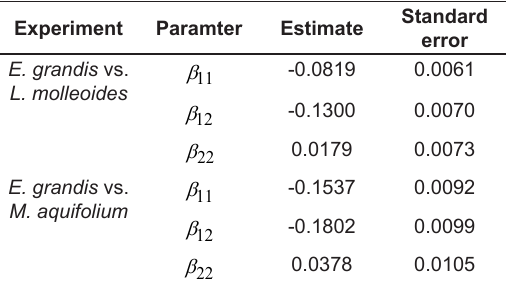
Table 4. Estimates and standard errors of the parameters of the two final